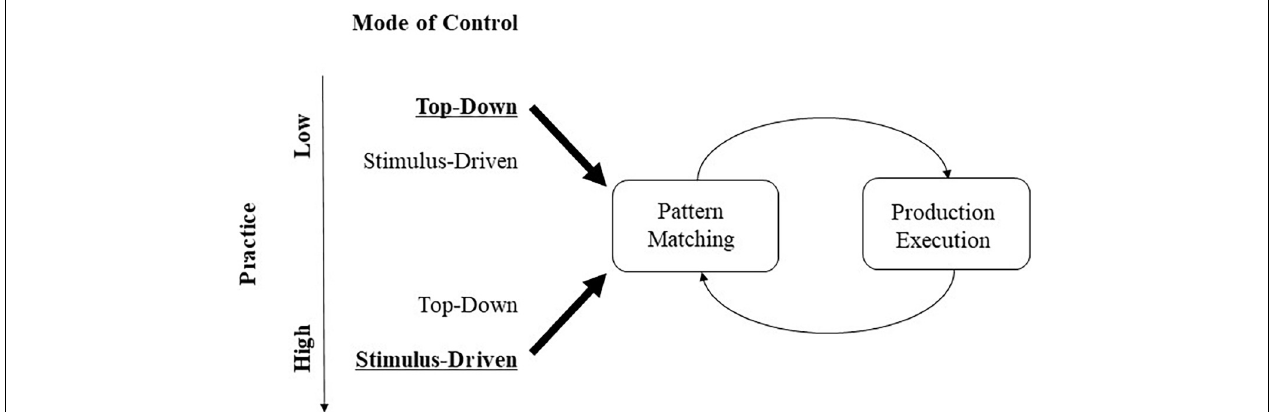
FIGURE 2 | Mode of control – top-down/by goals of the observer versus stimulus-driven – of covert and overt productions in long-term skill memory as a function of skill practice. All productions (e.g., linguistic/attentional, motor) are triggered by pattern matching (see boxes on the left), comparing an input stimulus to a specific template or parameter predefined as a critical precondition for the execution of the production, and the execution of the production itself (see boxes on the right) (Anderson et al., 2004). With practice (downward pointing arrow on the far left), control shifts from top-down, goal-directed selection of the production (top row), to stimulus-driven elicitation of the same production (bottom row). See text for additional